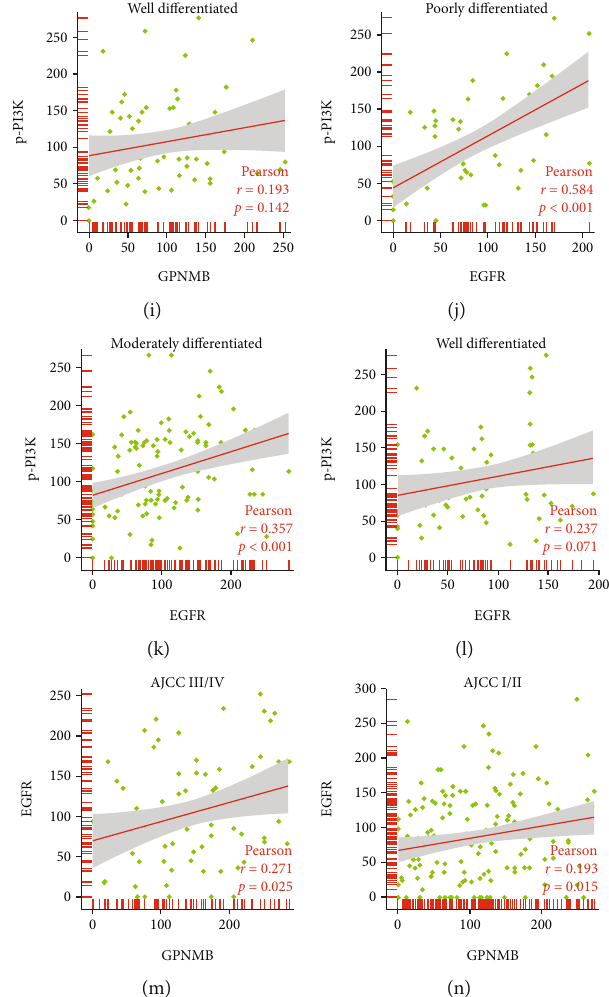
Figure 3: Correlation between GPNMB, EGFR, p-PI3K, and Ki-67. Pearson was used to analyze the correlation between (a) GPNMB and EGFR, (b) GPNMB and p-PI3K, (c) GPNMB and Ki-67, (d) EGFR and p-PI3K, (e) EGFR and Ki-67, (f) p-PI3K and Ki-67, (g – i) GPNMB and EGFR at di ff erent di ff erentiation levels, (j – l) EGFR and p-PI3K at di ff erent di ff erentiation levels, and (m, n) GPNMB and EGFR at di ff erent AJCC